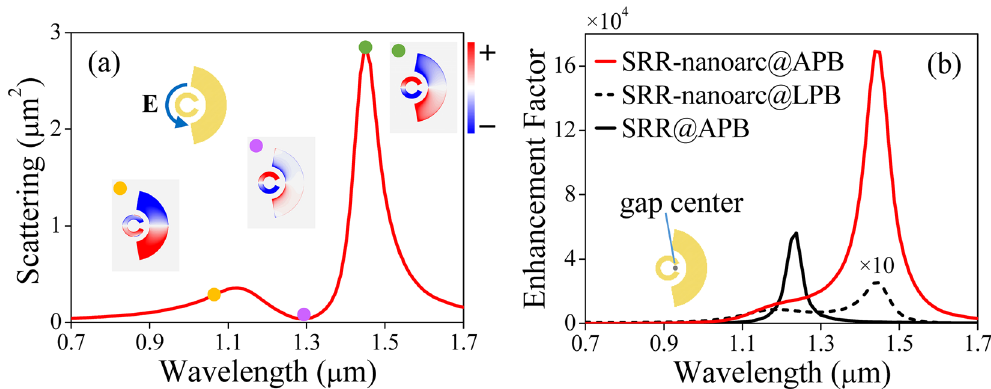
Figure 3. ( a ) Scattering spectrum of the SRR-nanoarc structure for the excitation of APB. The insets indicate the polarization of the excitation field and the charge distributions at the labeled wavelengths. ( b ) Enhancement factor (EF) of the SRR excited by APB (black solid curve) and the SRR-nanoarc structure illuminated by APB (red solid curve) and LPB (black dashed curve), where the EF for the excitation of LPB is multiplied by 10 for clear comparison. The inset indicates the gap center of